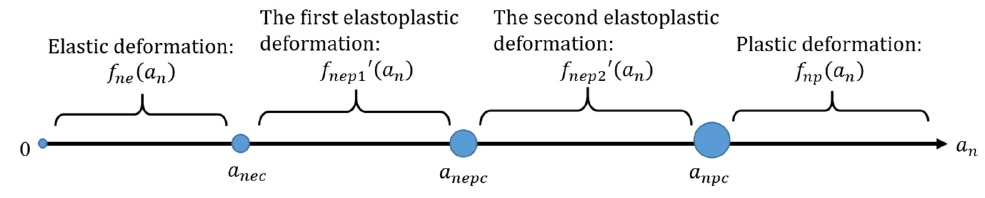
Figure 5. The diagram of the deformation law of a single asperity.